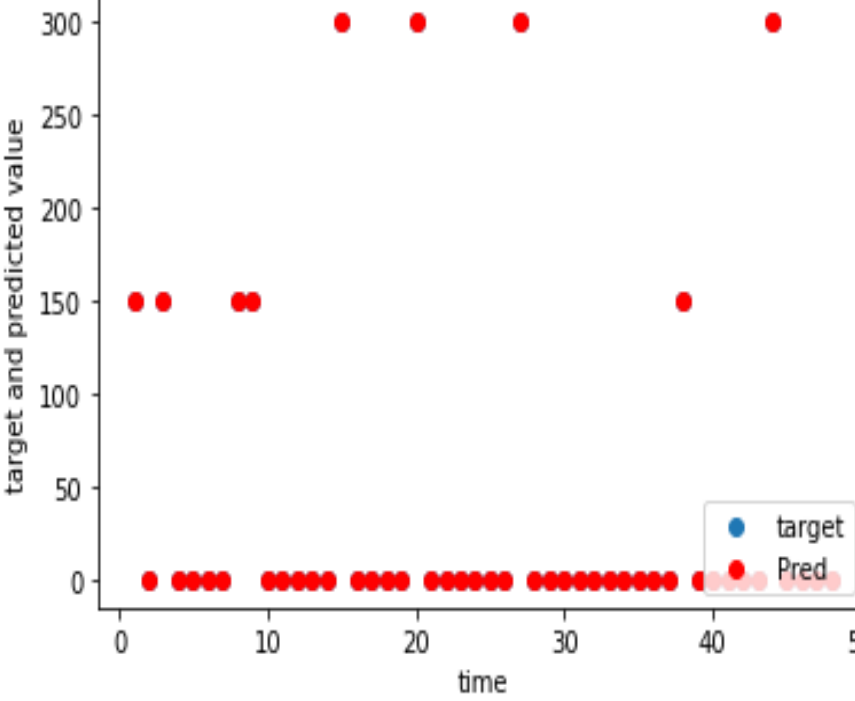
Figure 14. Charging demand prediction of a weekend for Tuomarilankallio.